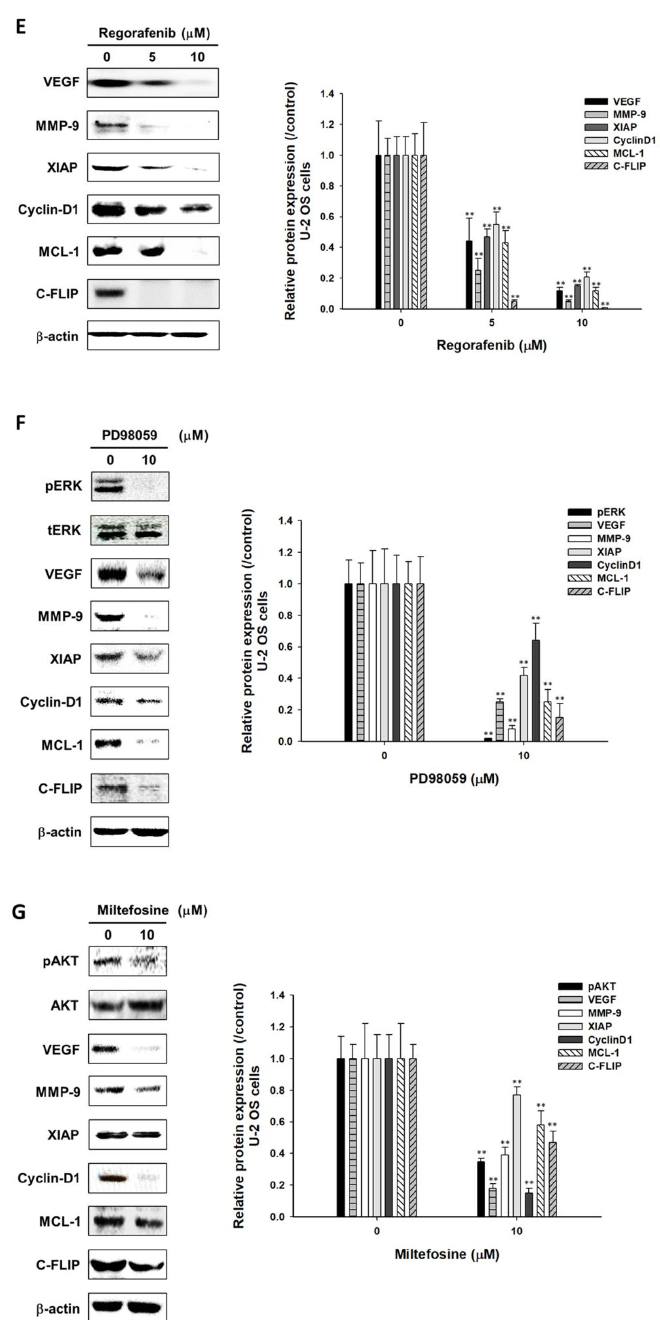
Figure 4. Tumor progression was blocked by regorafenib via inhibition of ERK and AKT signaling. U-2 OS cells were treated with 10 µ M of regorafenib, 10 µ M of PD98059 or 10 µ M of miltefosine for 48 h and followed by invasion assay. MG-63 cells were treated with 10 µ M of regorafenib. ( A , B ) Light view photographed images and quantification bar chart of each group. Three independent experiments of protein expression level of pERK and pAKT were detected and quantified after 0, 5 or 10 µ M of regorafenib treatment in ( C ) U-2 OS cells or ( D ) MG-63 cells. Protein level of VEGF, MMP-9, XIAP, CyclinD1, MCL-1 and C-FLIP of U-2 OS cells were measured after various treatments, including ( E ) 0, 5 or 10 µ M of regorafenib; ( F ) 10 µ M of PD98059; and ( G ) 10 µ M of miltefosine. ** p < 0.01 vs. 0 µ M treatment